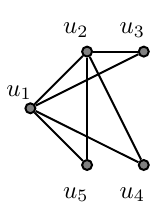
Figure 4: The graph G